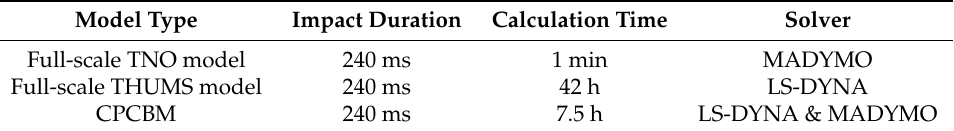
Table 4. Comparison of the computation time needed by di ff erent models.